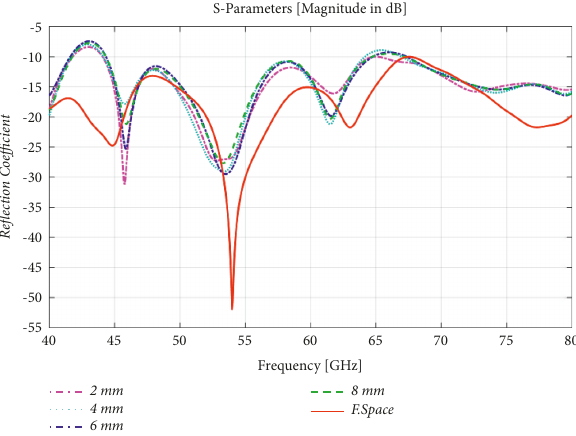
Figure 48: Return loss comparison of the 2 × 2 array antenna for different